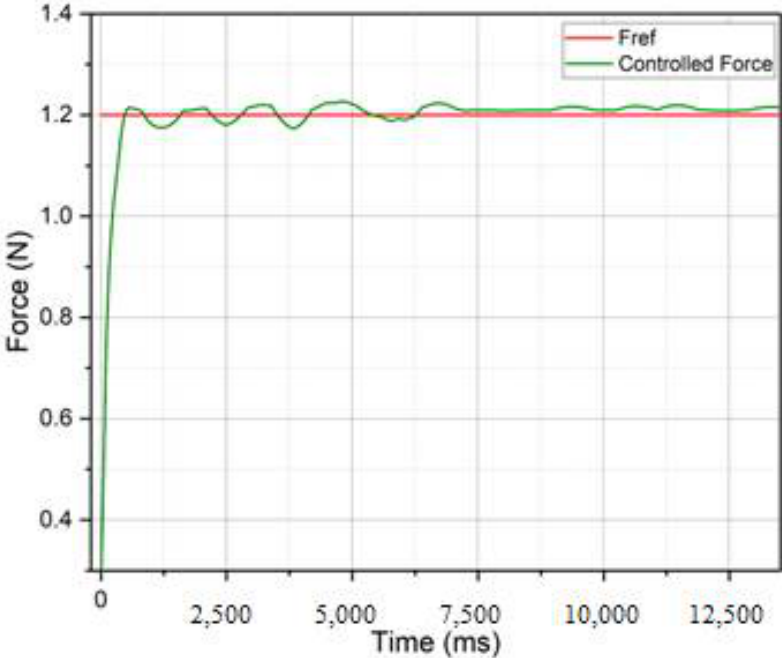
Figure 10. PID controller response for output feedback from the FSR sensors.